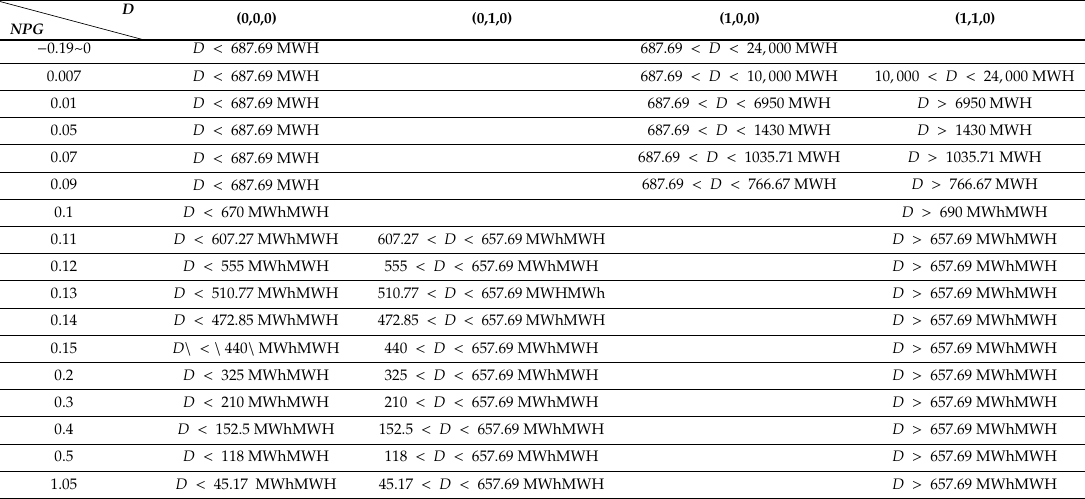
Table A4. Influence of NPG on electricity demand of power grid enterprises.